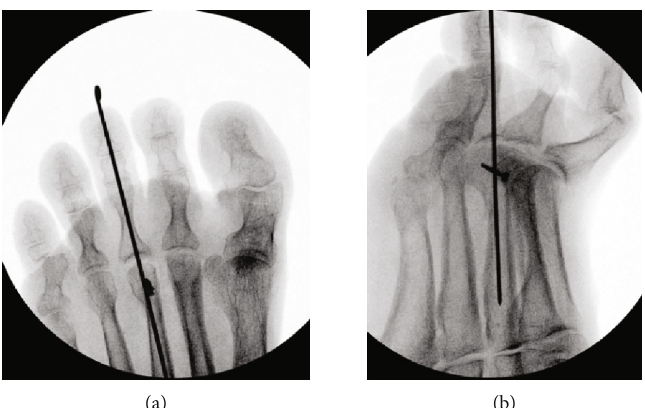
Figure 4: Intraoperative X-ray after realignment performing Weil ’ s osteotomy, extensor brevis transfer, and temporary arthrodesis of the second